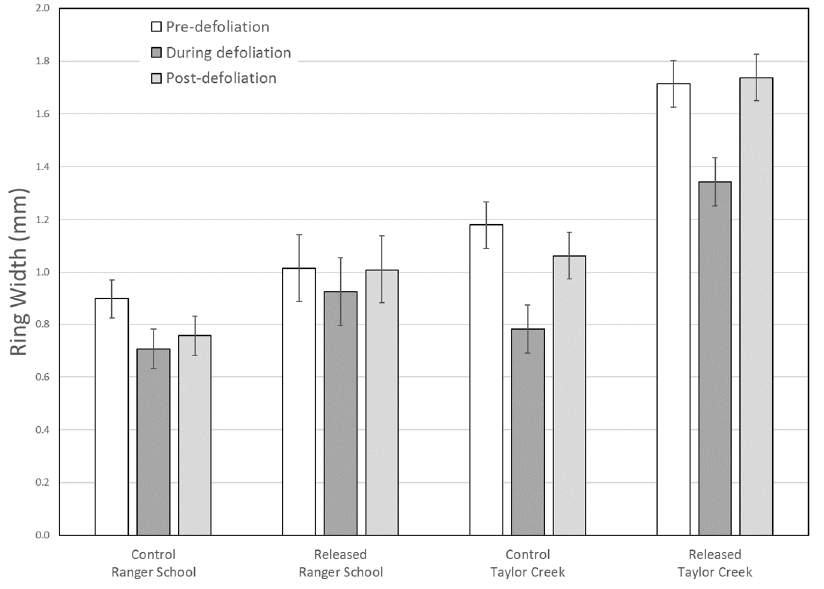
Figure 6. Mean ring width (mm) by site and treatment for 4 years pre-defoliation, 2–3 years during defoliation, and 4 years